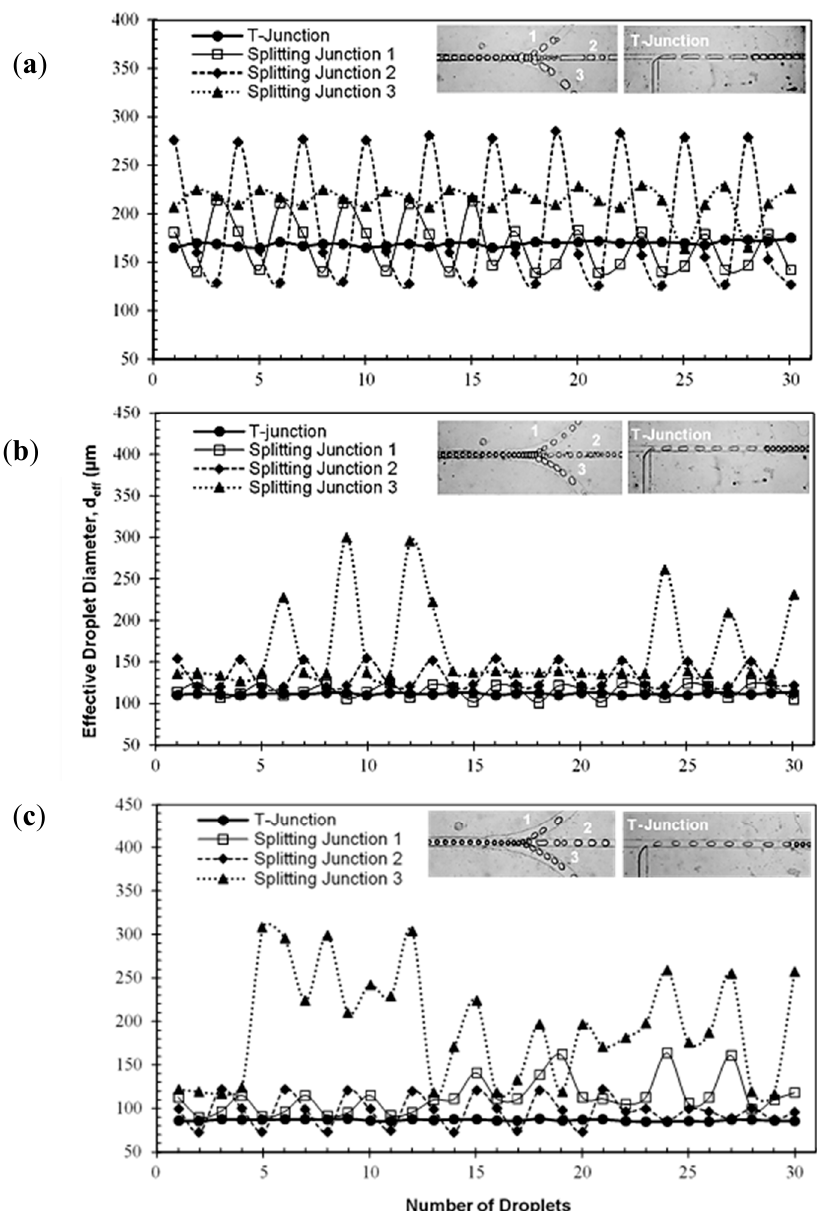
Figure 11. Droplet size distribution in di ff erent region of interests at Q c of ( a ) 0.5 mL / h; ( b ) 1.5 mL / h; and ( c ) 2.0 mL / h, respectively. The images were taken under the optical microscope using high speed camera.